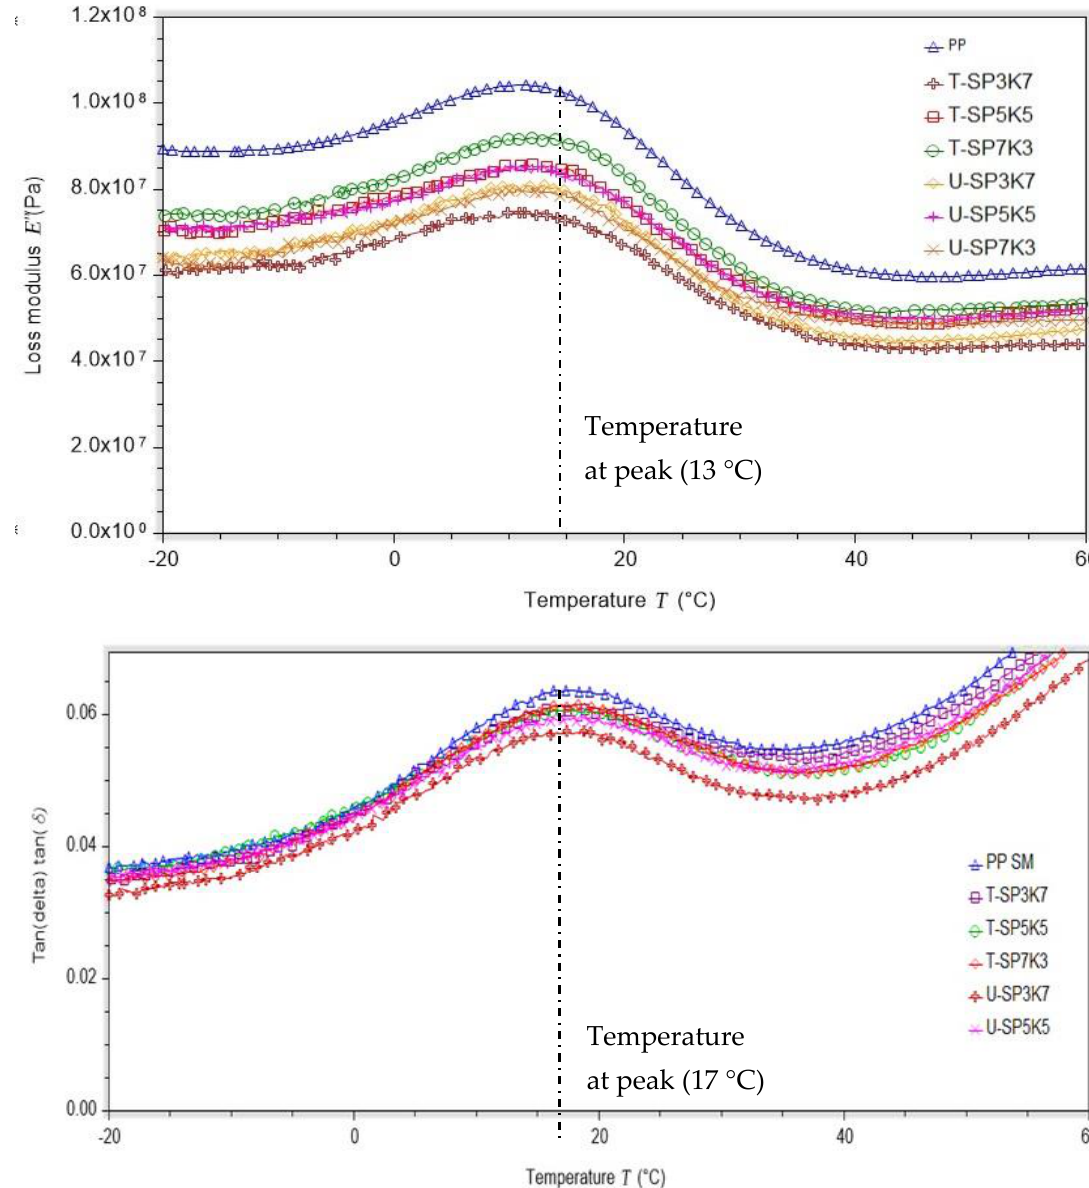
Figure 6. ( a ) Loss modulus at peak E” (Pa) and proportional to the temperature of varied composition of SP/K/SP hybrid composites; ( b ) Loss factor (damping) tan δ at peak in relationship with the temperature of varied compositions of SP/K/SP hybrid composite.